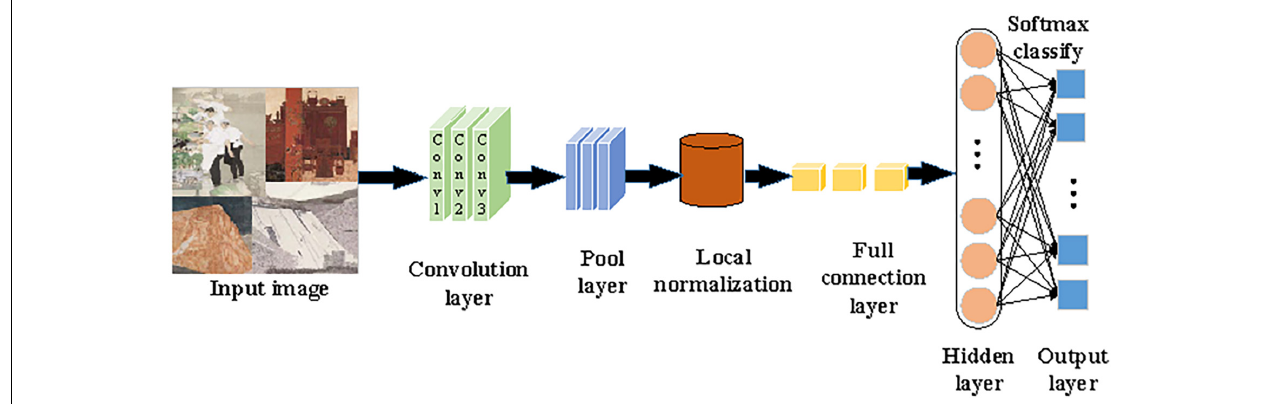
FIGURE 3 | Procedures of the improved AlexNet processing and recognizing Chinese